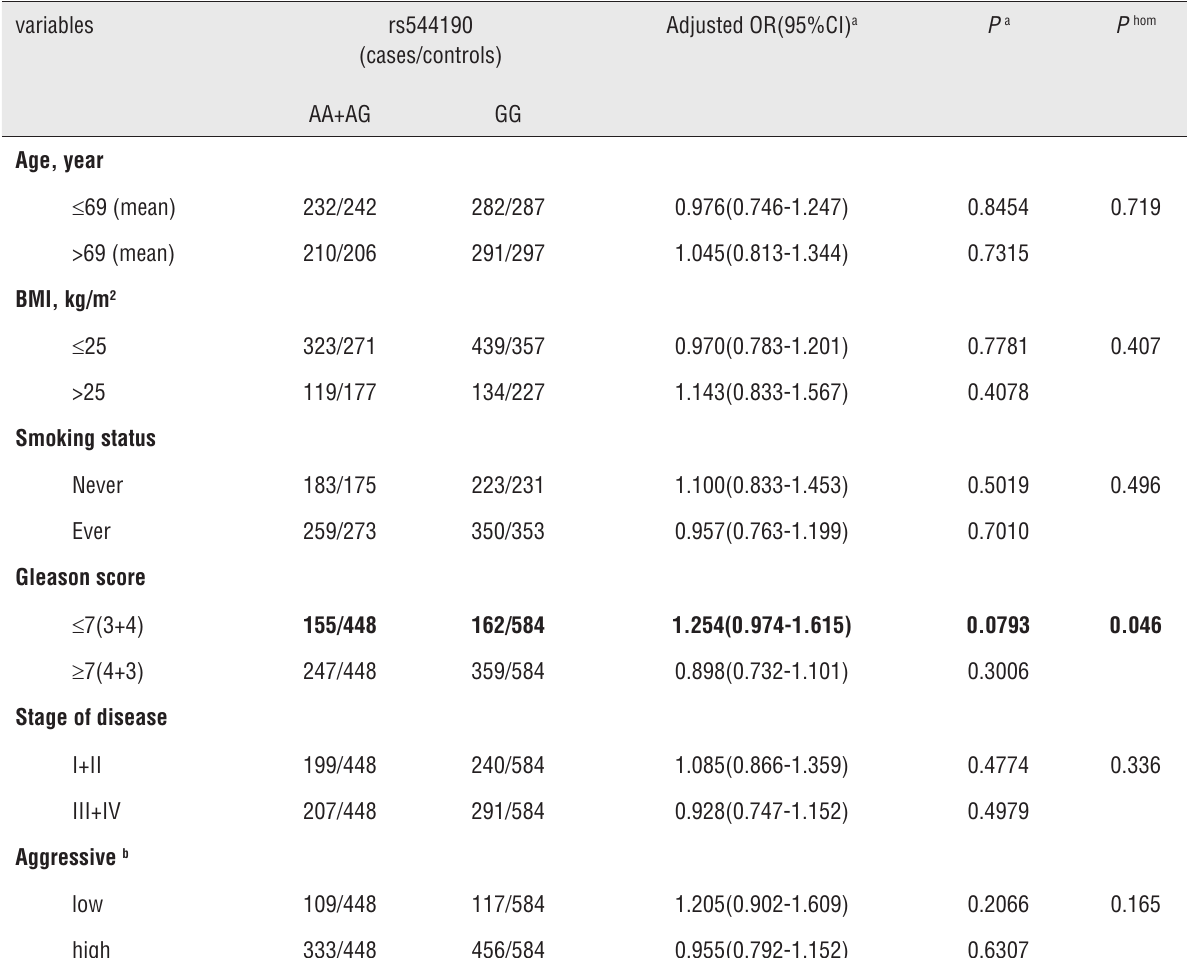
Table 2 - Stratification analysis for associations between pcA3 variant and prostate cancer risk by dominant genetic model in all subjects of Eastern chinese